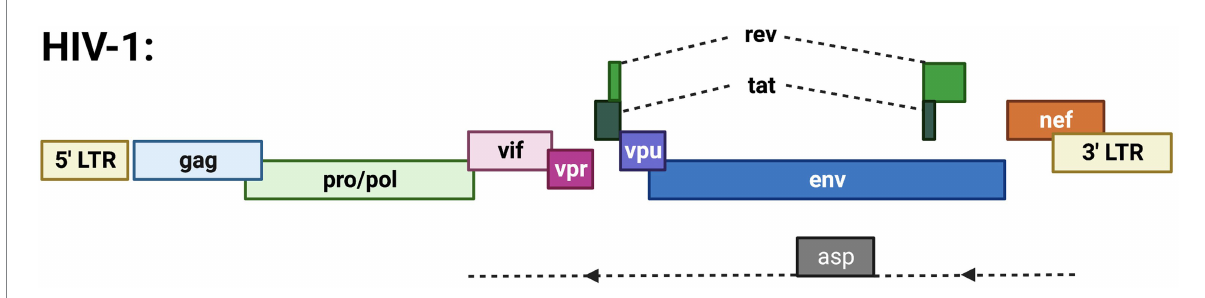
FIGURE 2 Schematic of the HIV-1 proviral genome highlighting known ORFs. Depicted are the gag, pro/pol, and env ORFs encoding the structural and enzymatic genes. Regulatory/accessory proteins encoded from the sense strand of the genome include Rev., Tat, Vif, Vpr, Vpu, and Nef. The only anti-sense derived protein is